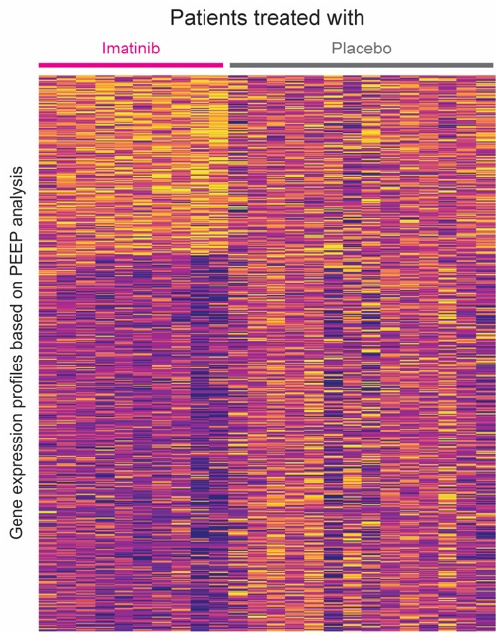
Figure 2. Gene expression profiles based on PEEP analysis. Gene expression profiles are compared based on imatinib or placebo-treated group.